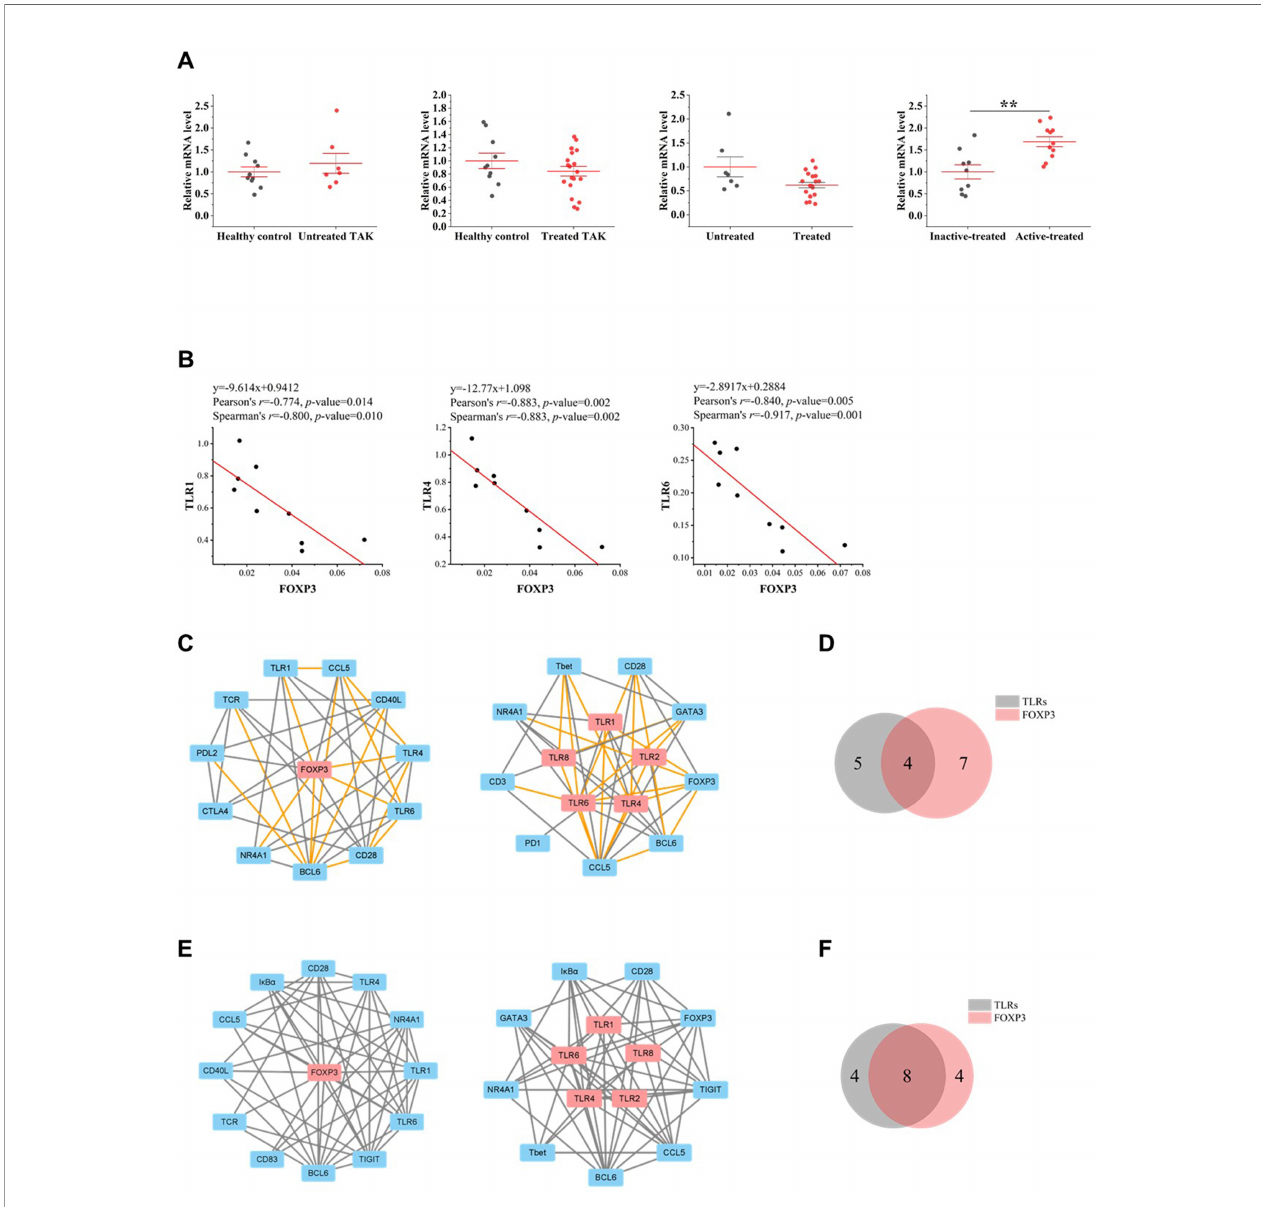
FIGURE 8 | The close functional relationship between FOXP3 and Toll-like receptors (TLRs) in inactive-treated TAK. (A) Gene expression differential analysis. Mann – Whitney test. ** p < 0.01. The red center line represented the mean value of the mRNA level, and the error bar showed the standard deviation. (B) The scatter plots and the linear regression of the FOXP3-TLR1 pair, the FOXP3-TLR4 pair, and the FOXP3-TLR6 pair in the inactive-treated TAK group, indicating that FOXP3 was co- expressed with multiple TLRs. (C)~(F) FOXP3 and TLRs shared multiple co-expressed genes. (C) The gene co-expression network consisting of FOXP3 (left panel) or TLRs (right panel) and its/their neighborhoods based on Pearson correlation. (D) Intersections of the neighborhood-gene between FOXP3 and TLRs based on Pearson correlation. (E) The gene co-expression network consisting of FOXP3 (left panel) or TLRs (right panel) and its/their neighborhoods based on Spearman correlation. (F) Intersections of the neighborhood-gene between FOXP3 and TLRs based on Spearman correlation. Healthy controls, n=10 people. Untreated TAK, n=7 people. Treated TAK, n=20 people. Active-treated TAK. n=11 people. Inactive-treated TAK, n=9 people. TAK, Takayasu ’ s